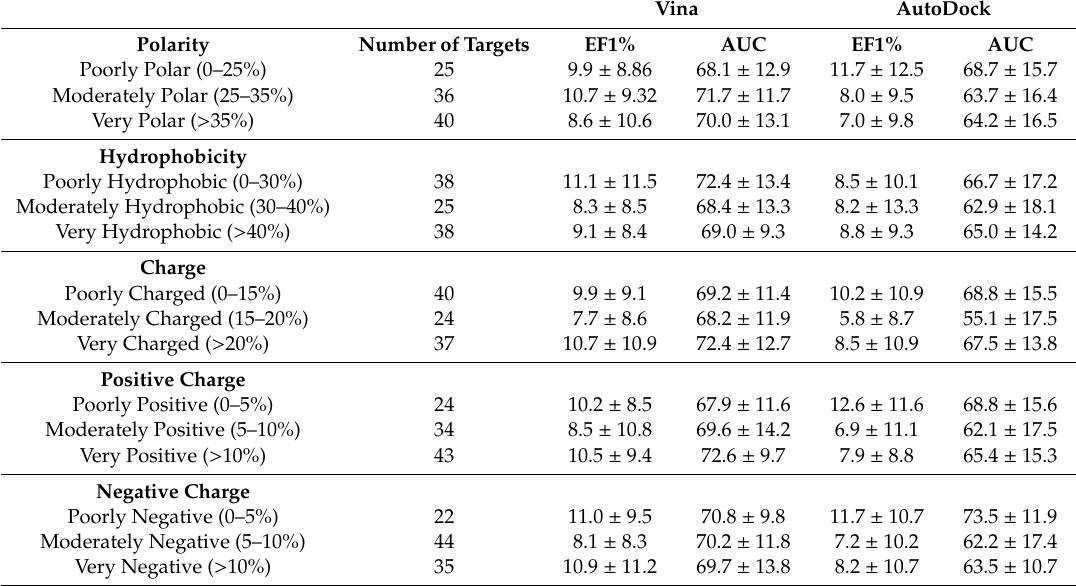
Table 4. Performance of Vina and AutoDock in the discrimination between ligands and decoys for targets with binding pockets with di ff erent percentages of polar, charged, and hydrophobic amino acid